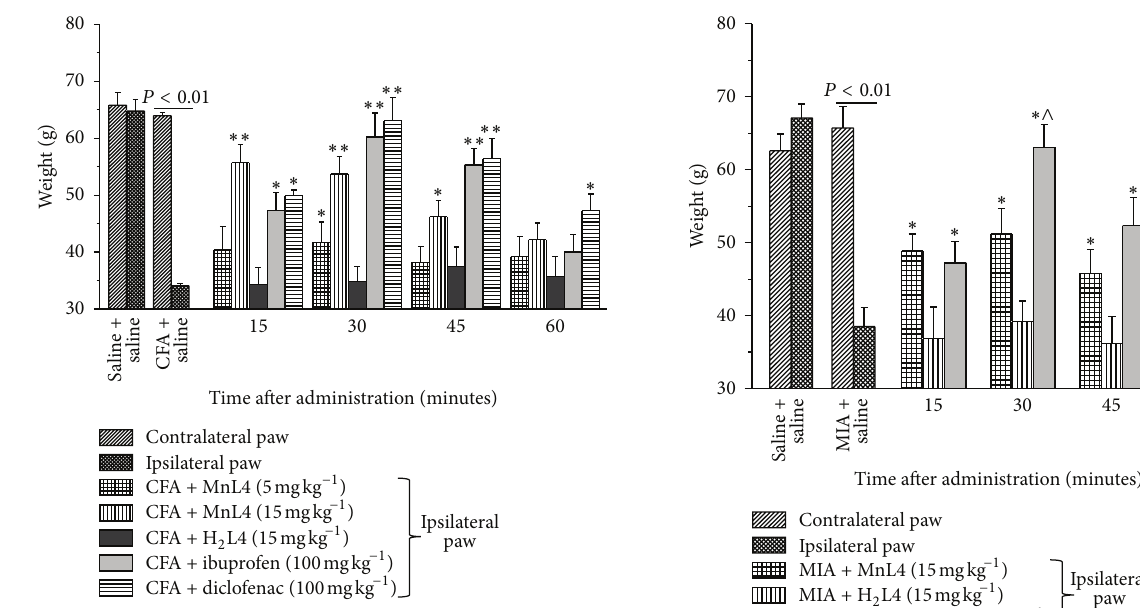
Figure 2: Effect of MnL4, H 2 L4, ibuprofen, and diclofenac on com- plete Freund’s adjuvant-induced inflammatory arthritis. Complete Freund’s adjuvant (CFA, 50 𝜇 L) was injected in the left posterior tibiotarsal articulation 7 days before the pain evaluation by the paw pressure test. Molecules or saline was administered i.p. at the indicated doses at time 0 and measures were performed at time 15, 30, 45, and 60 min. Values are the mean ± s.e.m. of 6 animals. ∗ 𝑃 < 0.05 and ∗∗ 𝑃 < 0.01 versus the ipsilateral paw of CFA + saline group.